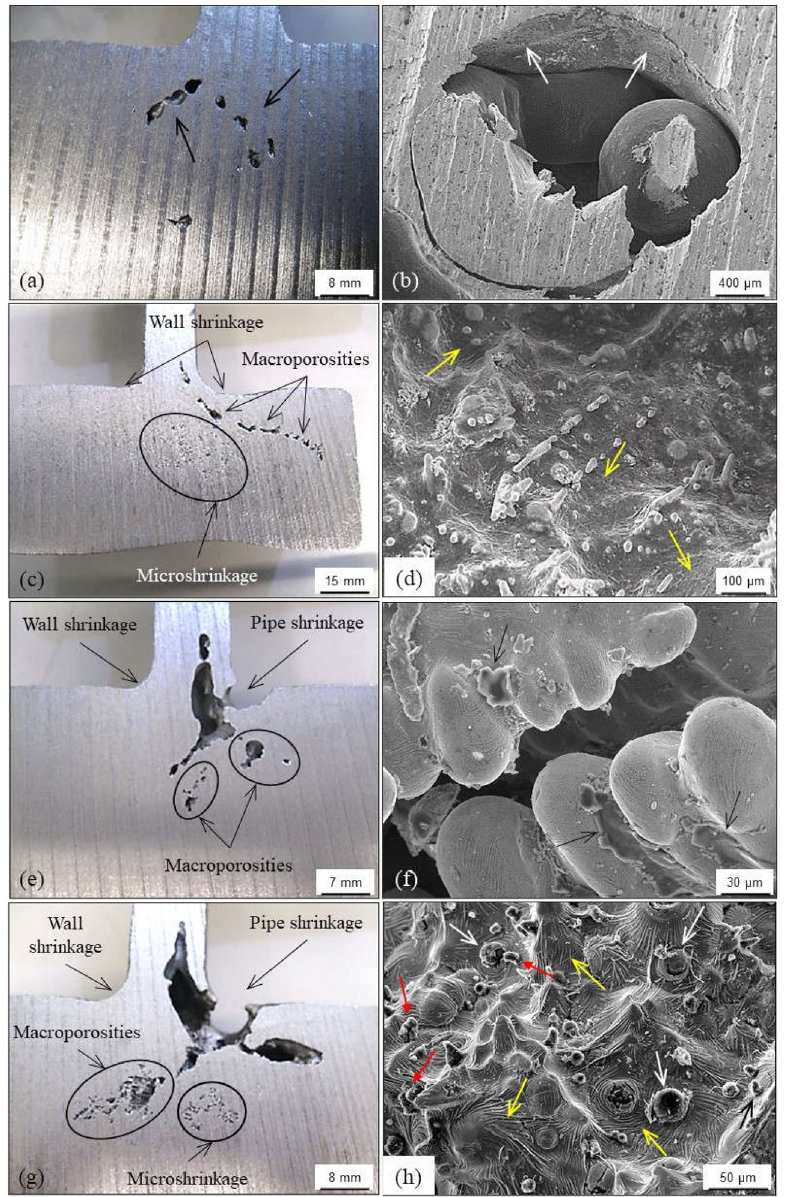
Figure 71. Different shrinkage defects found in ductile iron test castings manufactured with ( a , b ) an inoculated hypereutectic alloy; ( c , d ) a not-inoculated hypereutectic alloy; ( e , f ) an inoculated hy- poeutectic alloy; ( g , h ) a not-inoculated hypoeutectic alloy (Reprinted with permission from ref. [49]. Copyright 2017 Universitat de